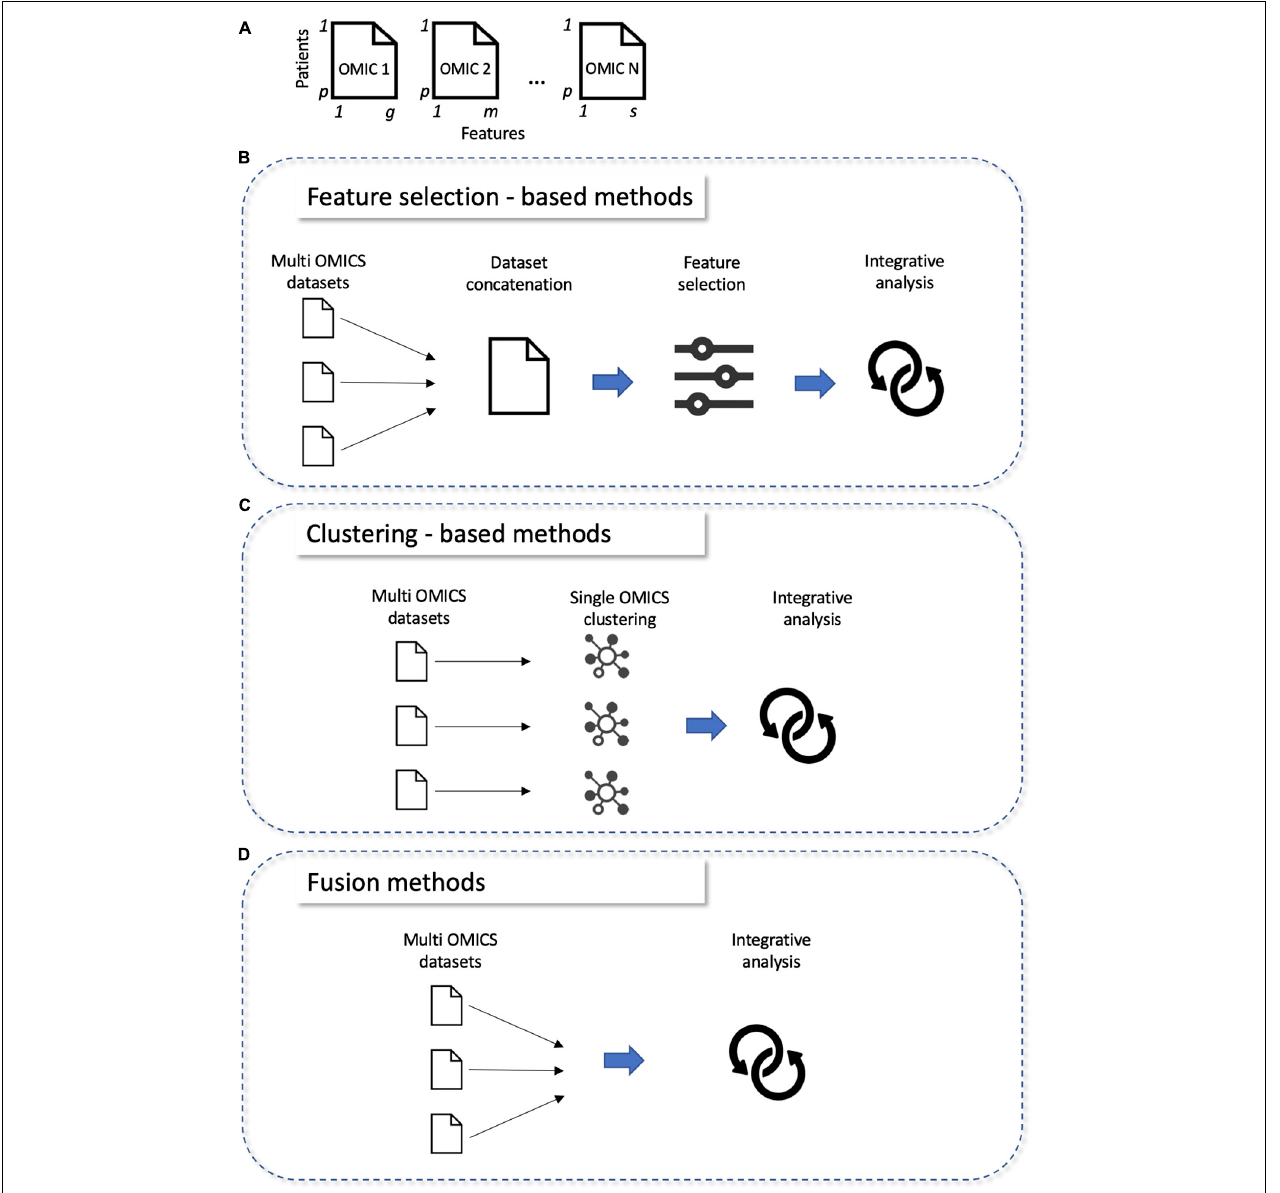
FIGURE 2 | Classifications of multi-omics integration methods. (A) Structure of omics data before integration: each omics (OMIC N) correspond to a matrix with p lines (patients) and g, m, or s columns (features). (B–D) New classification of omics integration tools: “Feature selection,” “Clustering,” “Fusion methods,” (B) single omics are integrated together, then a step of features selection is employed; (C) clustering is done at single omics level, then clusters are integrated together; (D) single omics are directly integrated